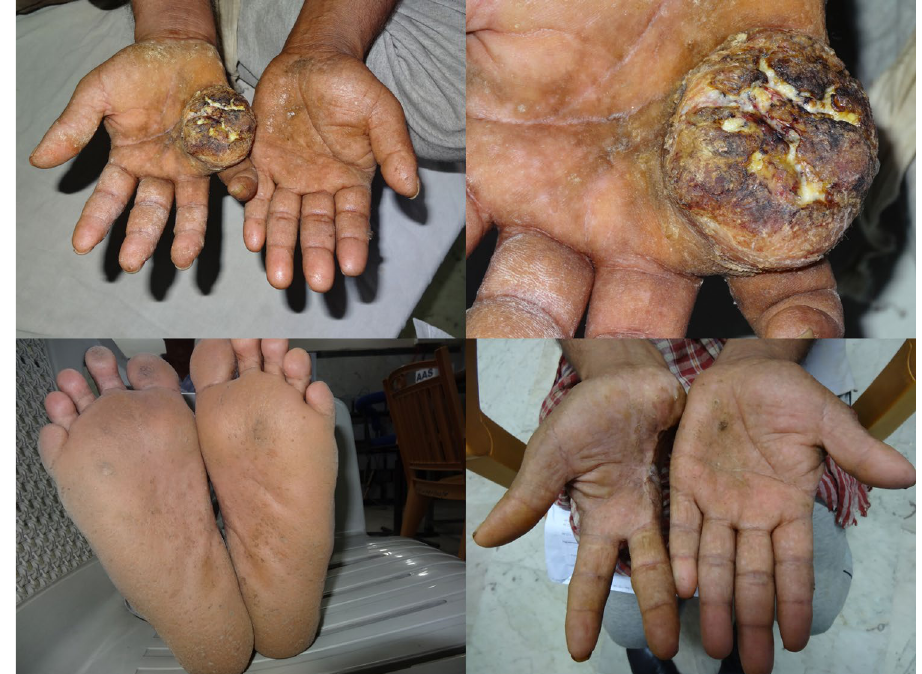
Figure 19. Showing a cancer patient with skin cancer (squamous cell of carcinoma) in his palm with typical arsenicosis symptoms in sole and